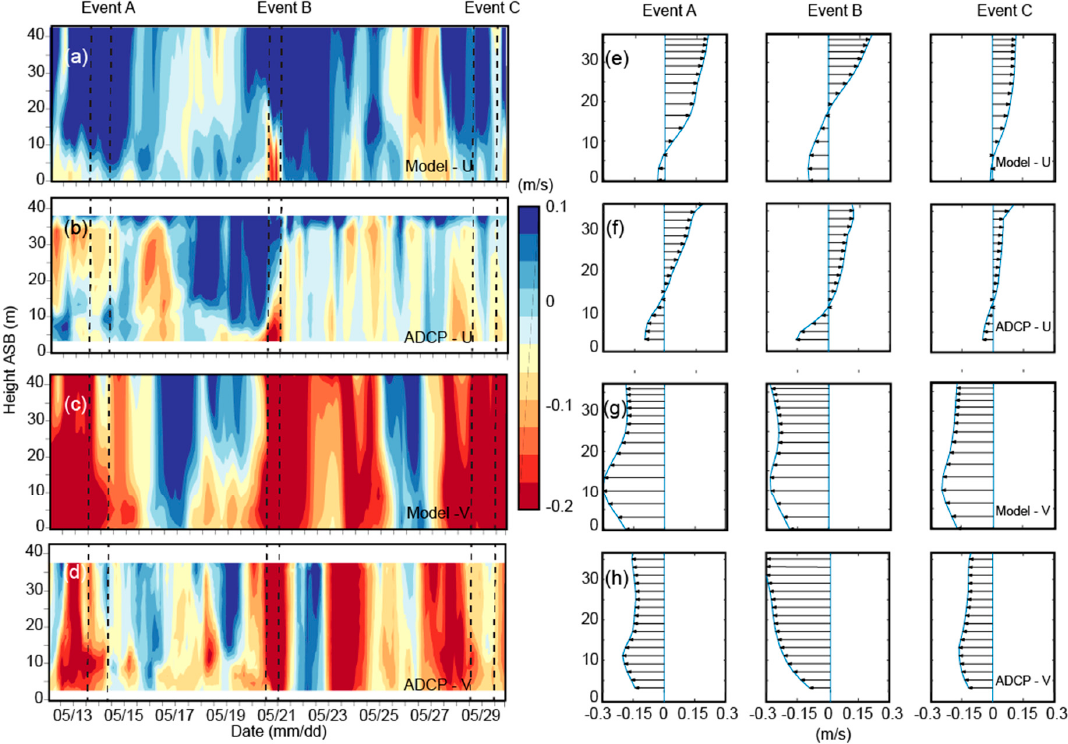
Figure 5. Time series (May 12–30, 2016) of ( a ) the predicted u-component of velocity, ( b ) observed u-component of velocity from ADCPs, ( c ) as for ( a ) for v-component velocities, ( d ) as for ( b ) for v-component velocities, ( e ) mean predicted velocity profile for each event for the u-component, ( f ) mean observed velocity profile for each event for the u-component, ( g ) as for ( e ) for v-component velocities, and ( h ) as for ( f ) for v-component velocities. Warmer colors represent flow to the west (u-component) and to the south (v-component). Dashed lines in panels a–d represent averaging periods for events in panels e–h.